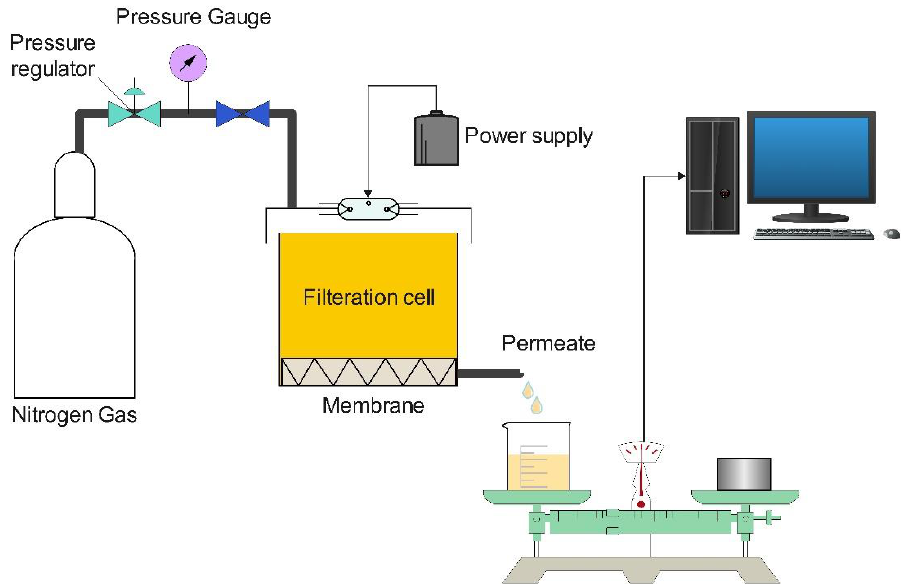
Figure 8. The experimental setup used in the study performed by Amoli-Diva et al. Reproduced with permission from [45]. Copyright © 2020, Elsevier.